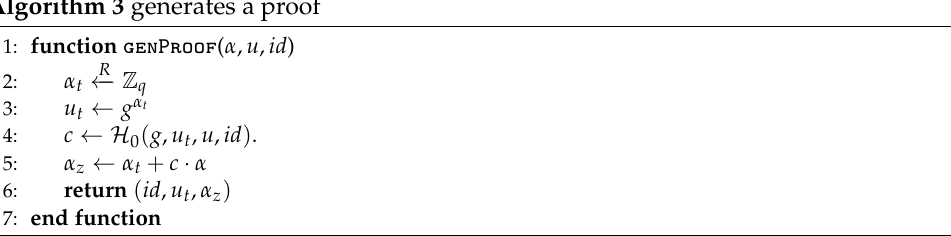
Algorithm 3 generates a